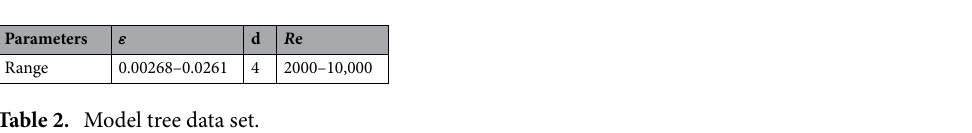
Figure 6. Relationship between absolute roughness and fractal roughness.